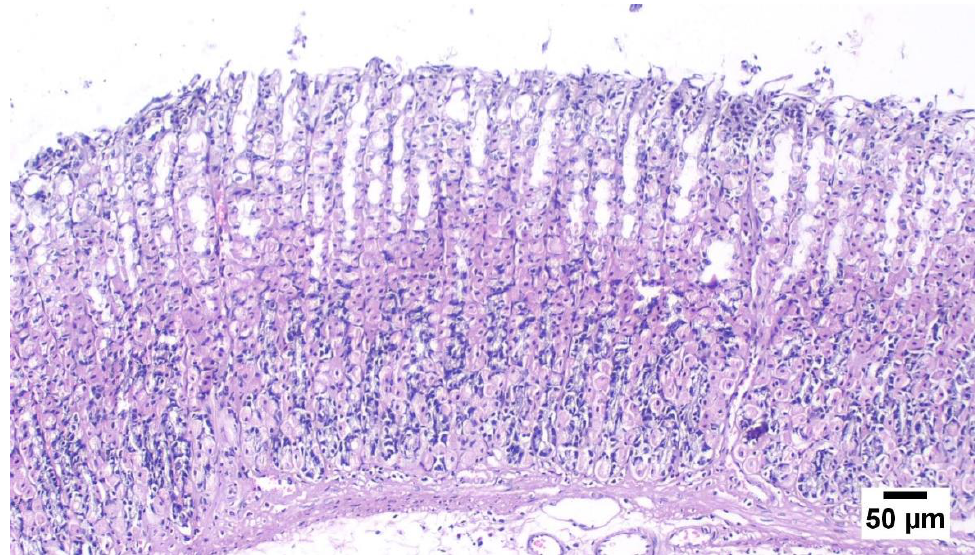
Figure 16. Photomicrograph of stomach, G2-D6-Asp , showing mild degeneration in the gastric glands (H&E).